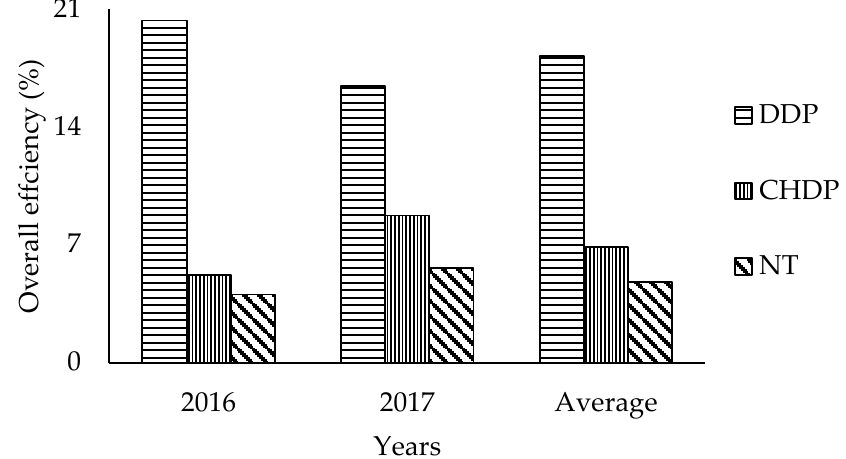
Figure 5. Overall e ffi ciency in the use of energy from fuel by the tillage Figure 5. Overall efficiency in the use of energy from fuel by the tillage systems.